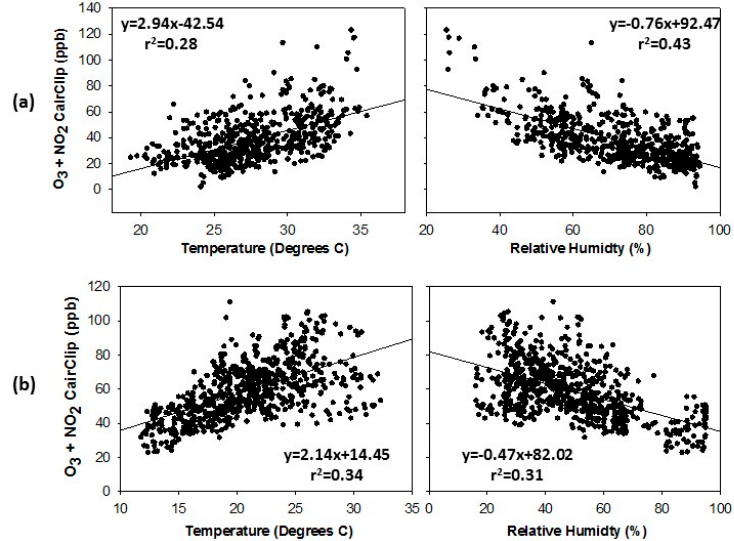
Figure A1. Scatter plots comparing CairClip O 3 /NO 2 sensor measurements to temperature and relative humidity in ( a ) Houston campaign and ( b ) Denver campaign.